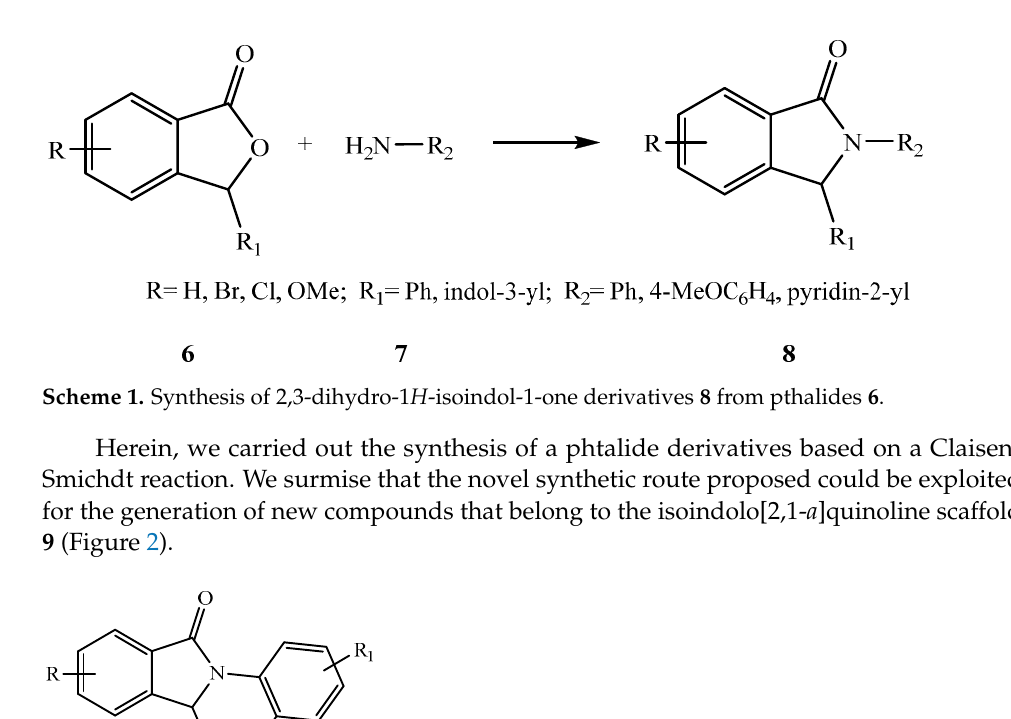
Figure 2. General structure of the target isoindolo[2,1- a ]quinoline